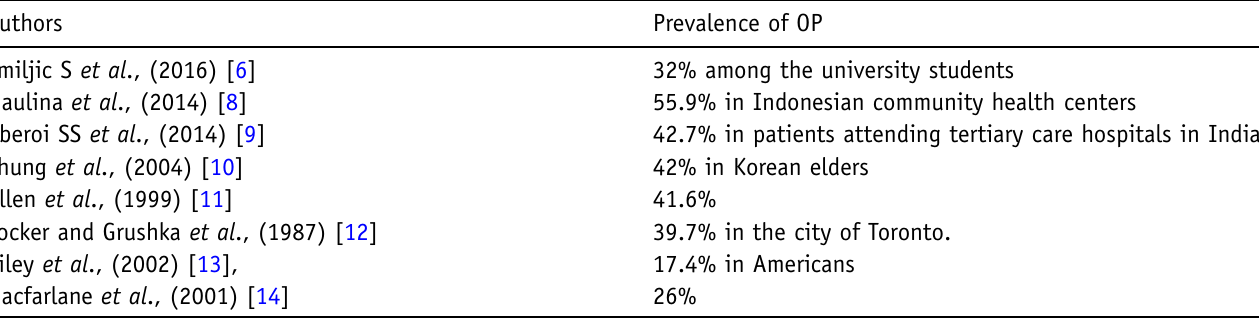
Table IV. Prevalence of OP reported in the